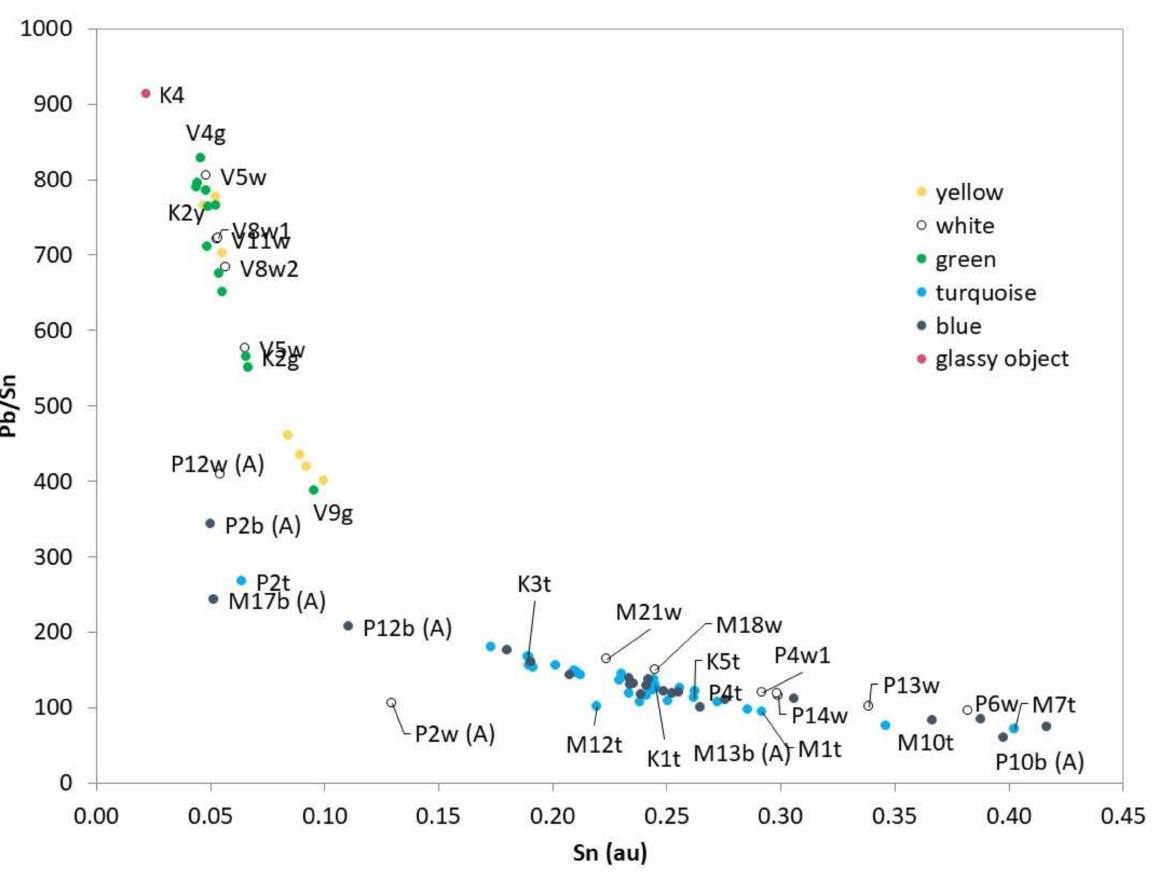
Figure 6. Scatter plot of XRF counts in arbitrary units of tin against the lead/tin